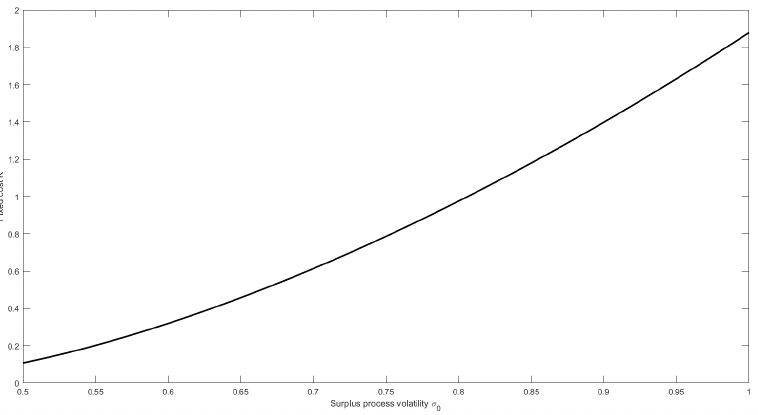
Figure 3. The effect of the volatility parameter σ on K ∗